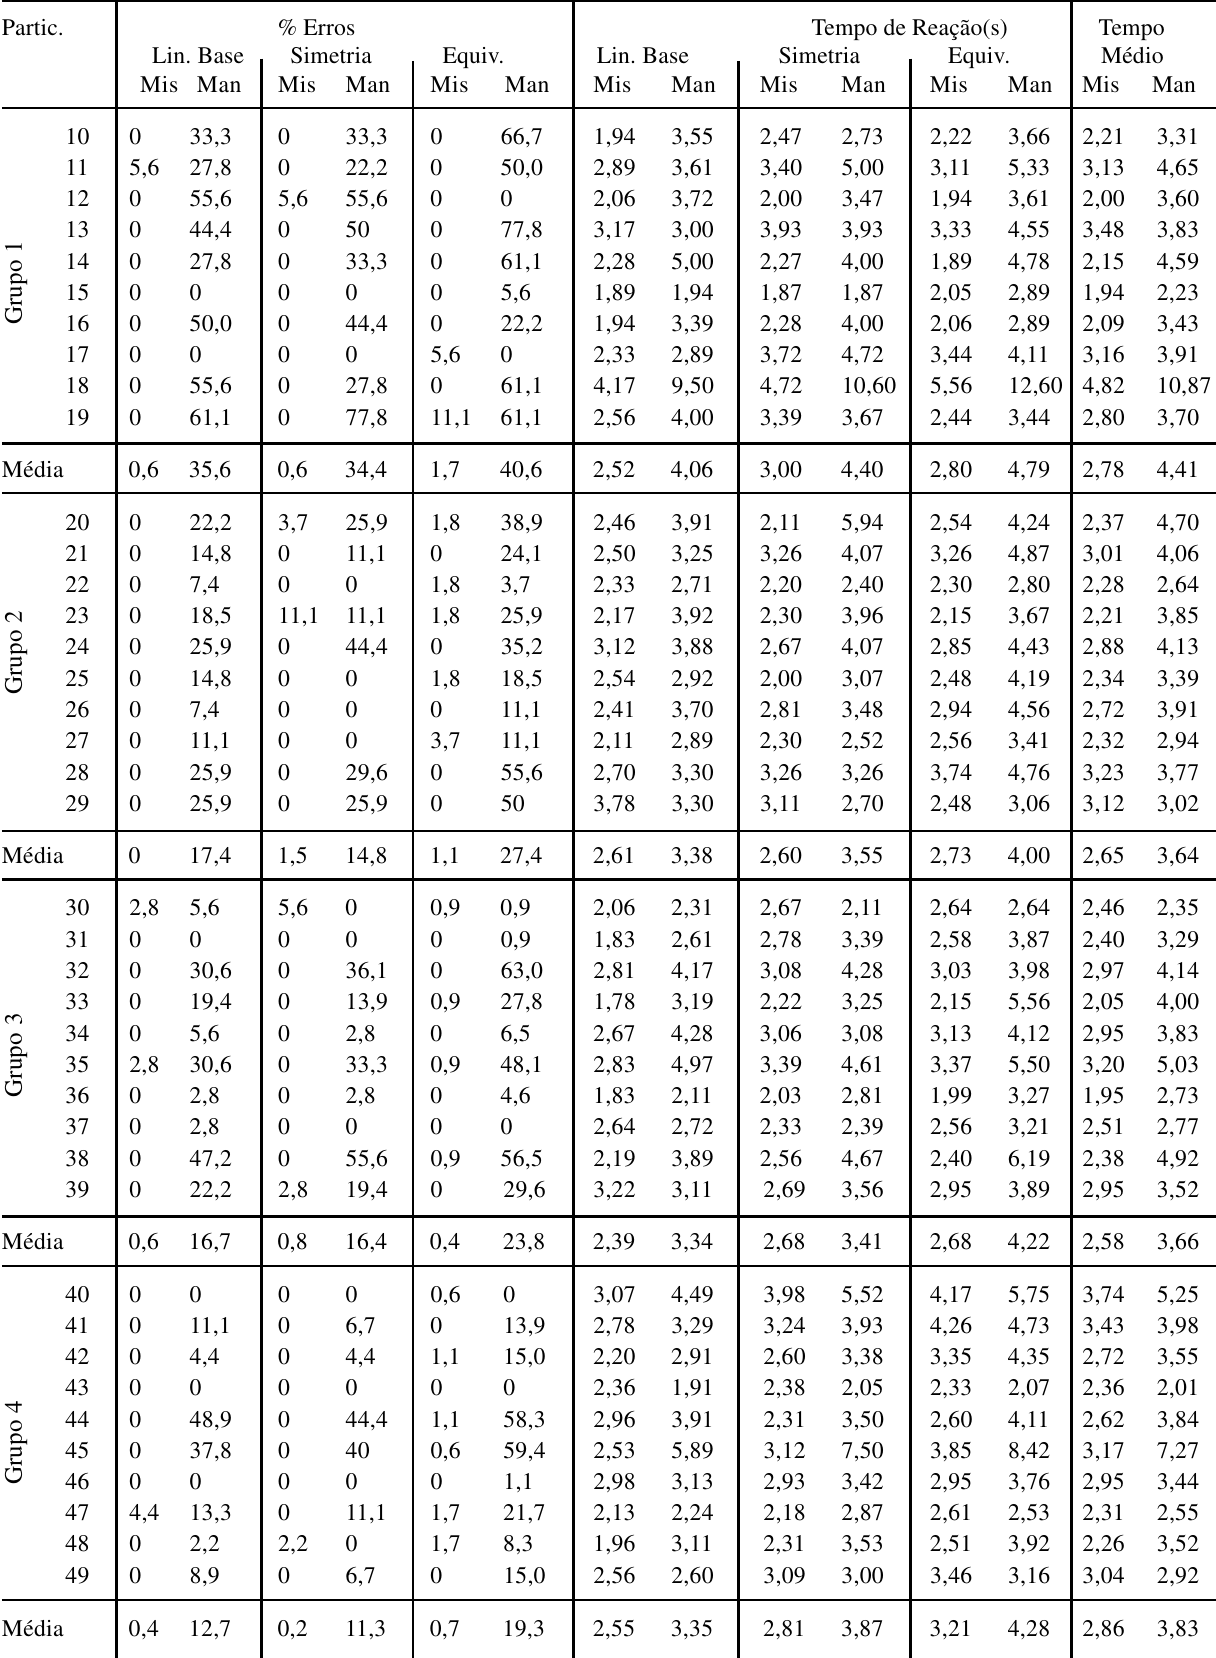
Tabela 5 Tempo Médio de Reação e Porcentagem de Erros no Teste Misto (Mis) e de Manutenção (Man)